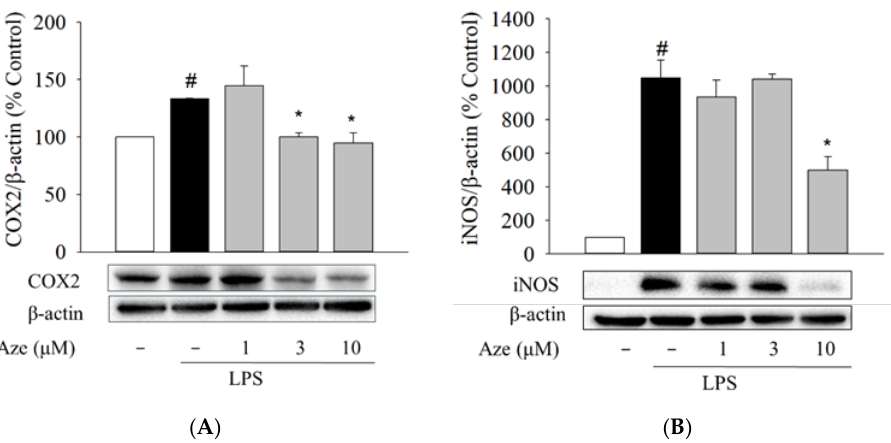
Figure 4. Aze suppressed the LPS-stimulated production of pro-inflammatory molecules in BV2 cells. Cells were treated with LPS (1 μg/mL) and the indicated concentrations of Aze. Control cells were treated with vehicle only. Culture media were collected after 24 h of treatment, and the levels of IL-6 ( A ), TNF-α ( B ), and NO ( C ) were determined as described in the Materials and methods. Data are presented as the mean ± SEM from three independent experiments. # p < 0.05 and * p < 0.05 vs. vehicle-treated control and LPS-treated cells, respectively.